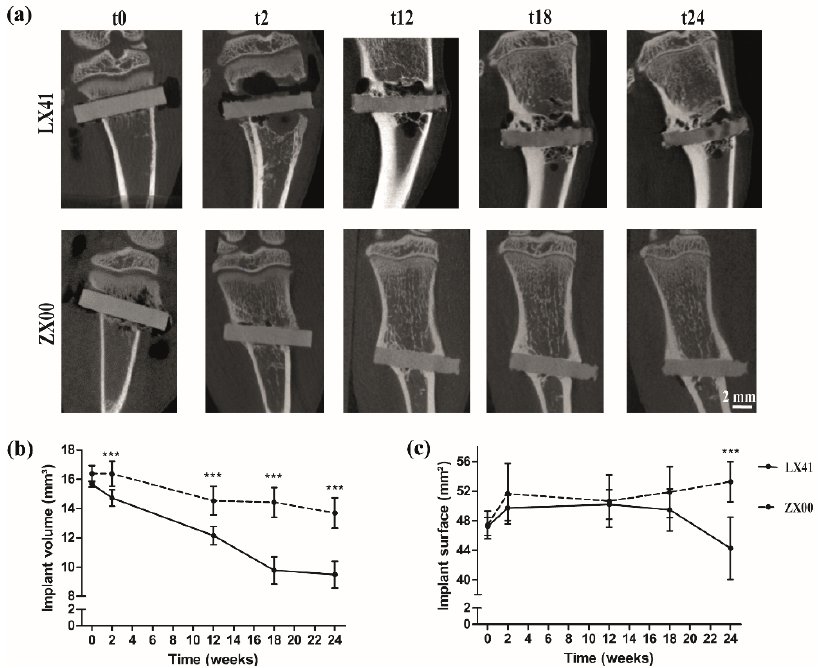
Figure 5. ( a ) In vivo observation of LX41 implant degradation over 24 weeks by μ CT imaging. ( b ) Implant volume and ( c ) implant surface area of ZX41 were quantified and compared to ZX00 over a period of 24 weeks (ZX00 reference data published elsewhere [24]). Data in ( b , c ) are given as a mean ± SD. *** p ‐ value < 0.001.